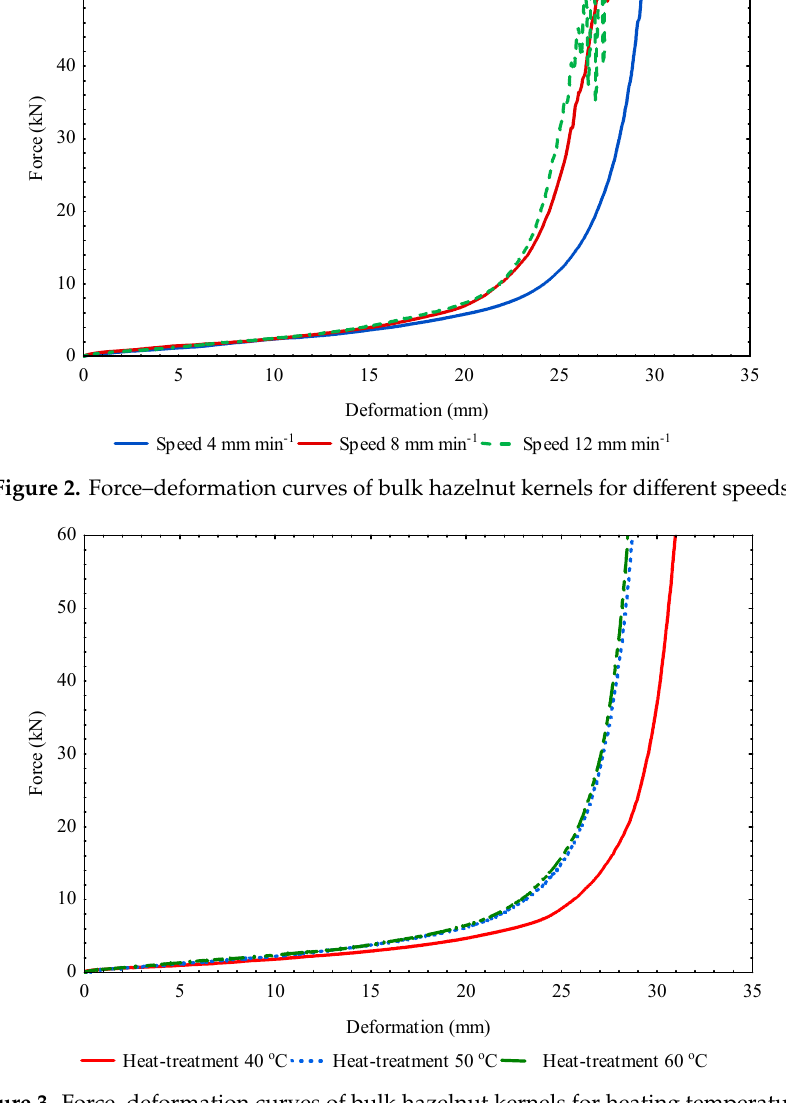
Table 4. Strain and oil point force of deformation levels of kernels at a speed of 4 mm / min.